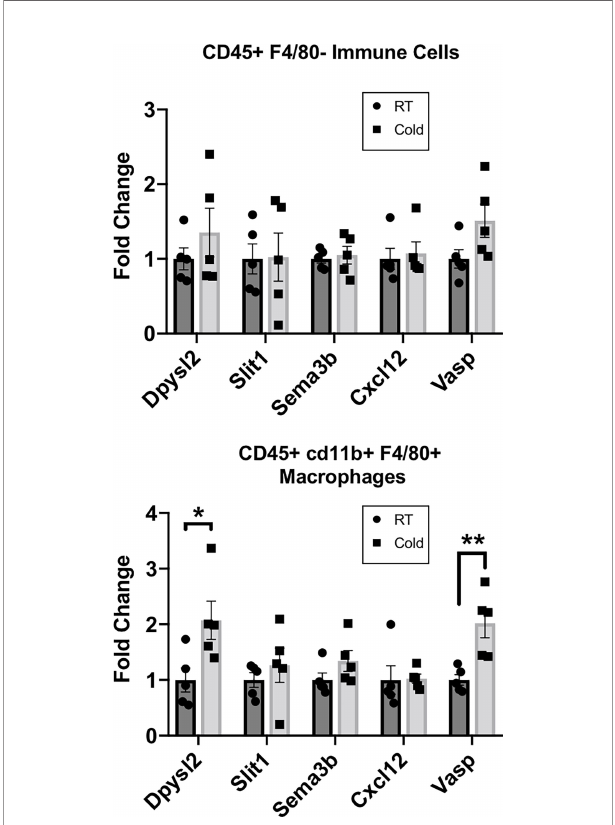
FIGURE 2 | RT-qPCR of adipose stromal vascular fraction (SVF) cells following 5 days of cold exposure. Relative gene expression of select axonal guidance markers in myeloid immune cells (CD45+cd11b+/) and macrophage populations (CD45+ cd11b+F4/80+) sorted via magnetic-activated cell sorting from scWAT SVF of room temperature mice and cold-exposed (5°C) mice for 5 days. Adult (at least 12 weeks old) C57BL/6J male mice were used; N = 4 RT, N = 5 cold-exposed. Gene expression is shown as fold change in DD Ct values, normalized to room temperature control mice. Error bars are shown as SEM. *p-value < 0.05; ** p -value ( Figure 3E ) and on myeloid-lineage SVF cells in inguinal scWAT ( Figure 3F ) using the post-synaptic marker PSD95.